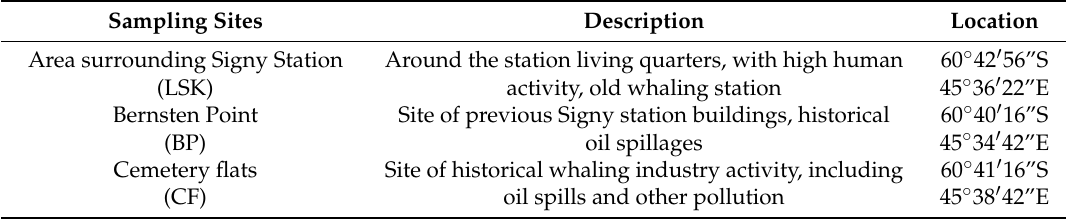
Table 2. The study sites sampled on Signy